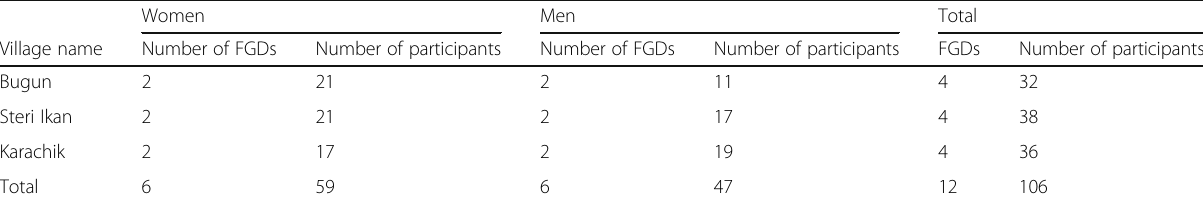
Table 1 Focus group formations by